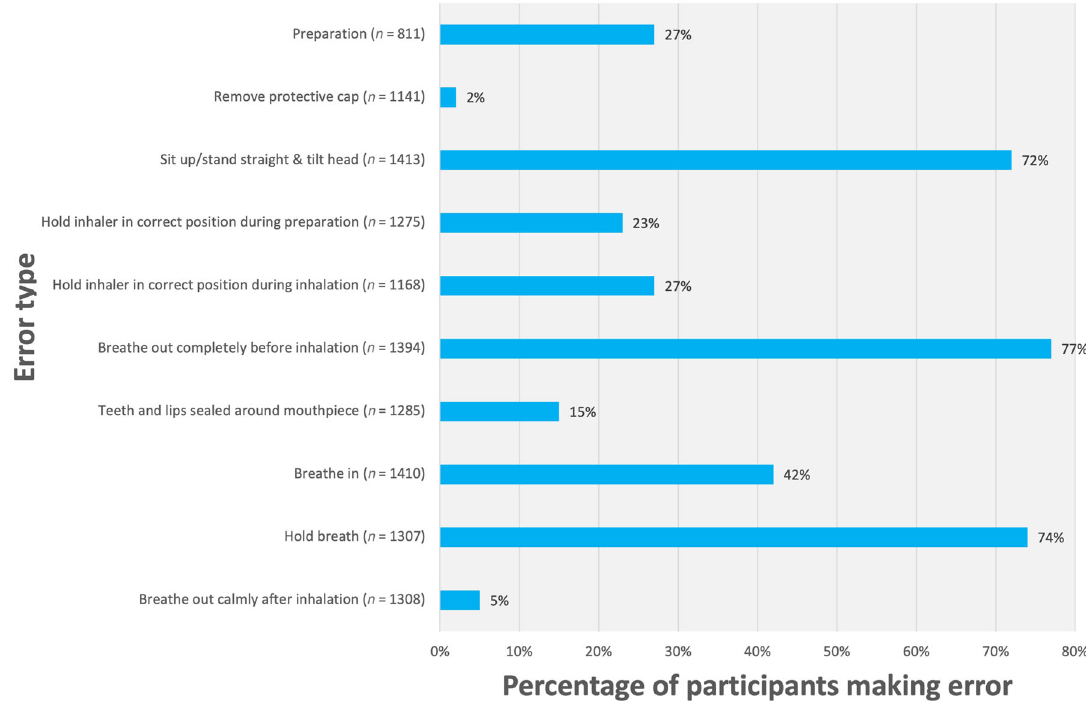
Fig. 3 Frequency of observed inhalation technique errors. Inhalation technique was evaluated by grouping errors into distinct categories ( y-axis ), and the percentage of participants in this study making these errors are presented ( x-axis